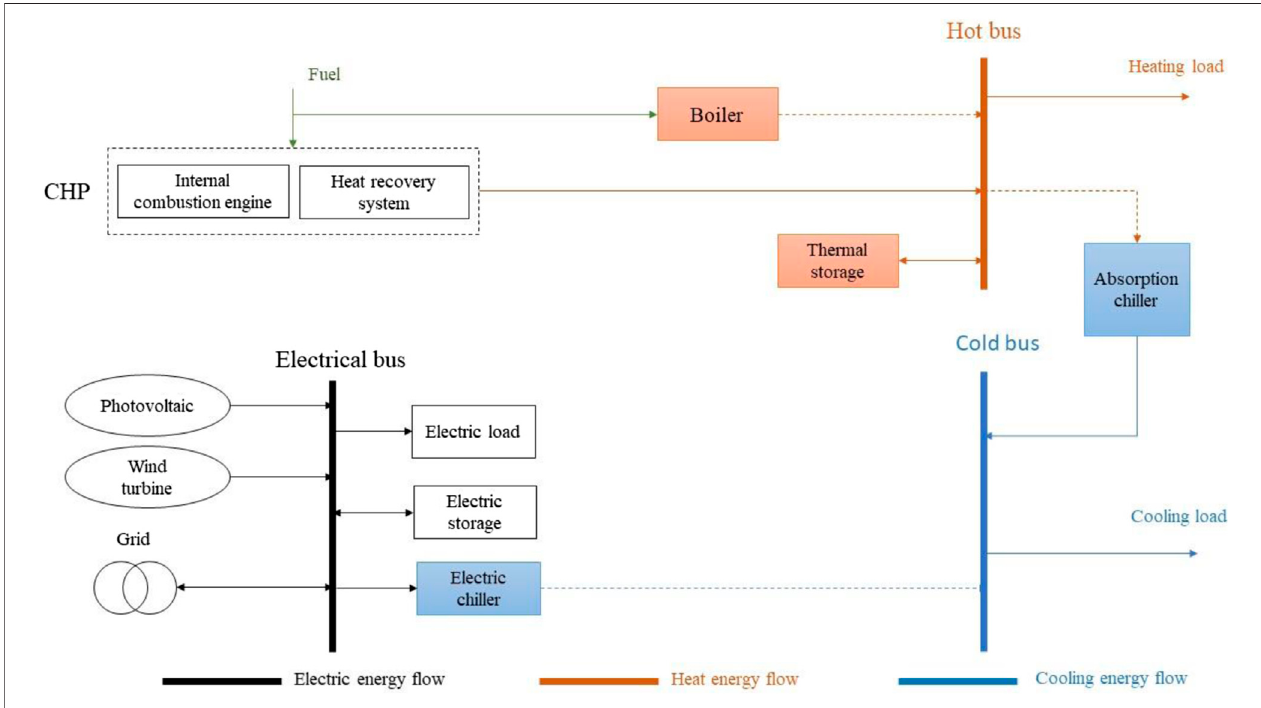
FIGURE 1 | Illustration of the integrated energy system